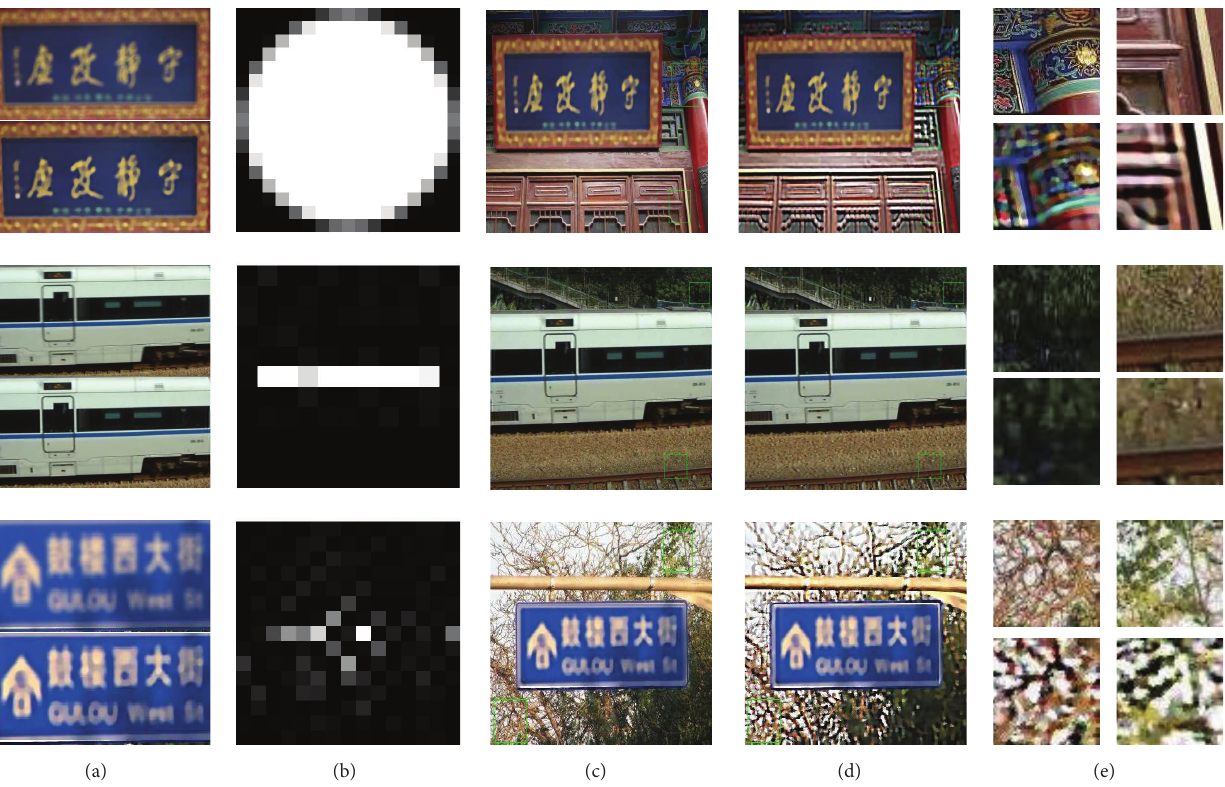
Figure 6: Comprehensive experiment. (a) The upper image is the extracted blurred region from Figure 3(a); the under image is its restored version. (b) The estimated blur kernel. (c) Final result. (d) Result using the same blur kernel for the whole image. (e) The upper images are the detailed images of (c); the lower images are the detailed images of